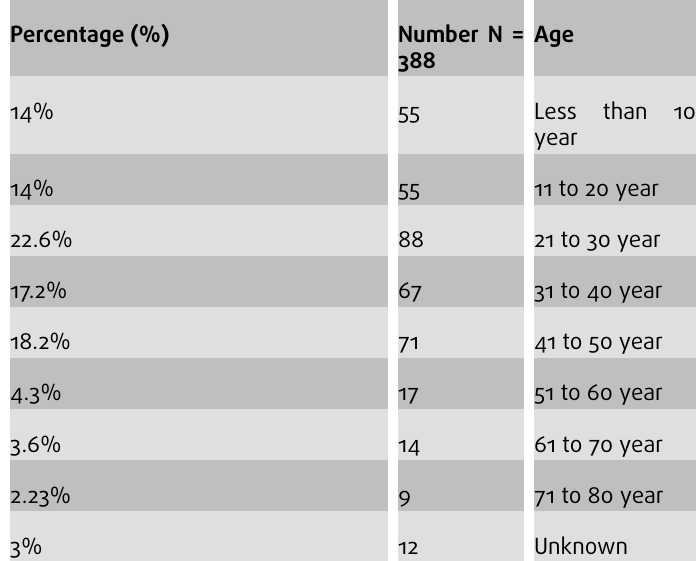
Table 2: Frequency distribution of MN by age among patients attending KAAUH between January 2000 and December 2017.